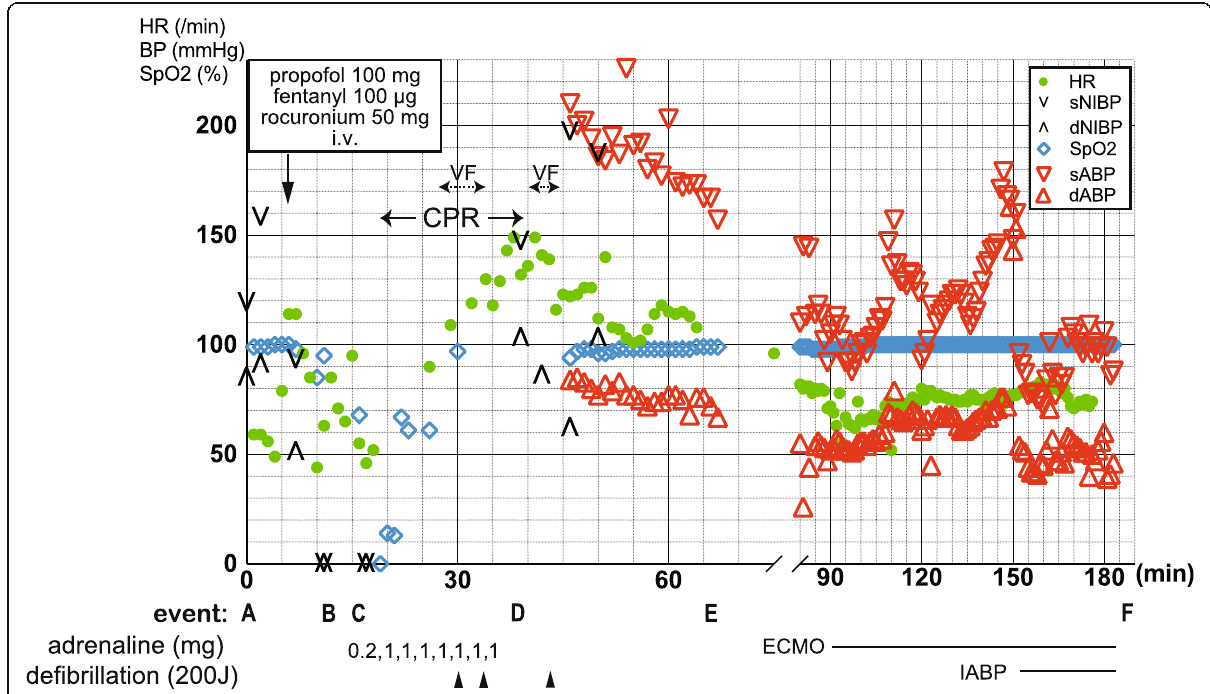
Fig. 2 Intractable circulatory collapse following the induction of general anesthesia for skin surgery. a Start of anesthesia, ( b ) Oral intubation, ( c ) Emergency call, ( d ) Recovery of spontaneous circulation, ( e ) Transfer to hybrid room, ( f ) Transfer to the intensive care unit. HR, heart rate; BP, blood pressure; SpO 2 , arterial oxygen saturation; s/dNIBP, systolic/diastolic non-invasively measured blood pressure; s/dABP, systolic/diastolic blood pressure measured through the arterial line; VF, ventricular fibrillation; CPR, cardiopulmonary resuscitation; ECMO, extracorporeal membrane oxygenation; IABP, intra-aortic balloon pumping